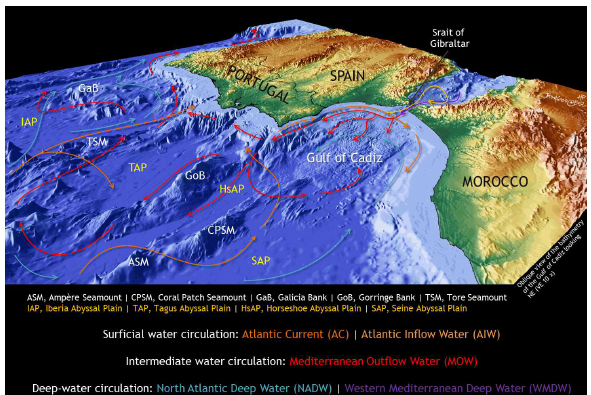
Figure 1. Scheme where the circulation of the major bodies of water in the Gulf of Cadiz and west of Portugal is shown (adapted from Hernandez - Molina et al., 2011).